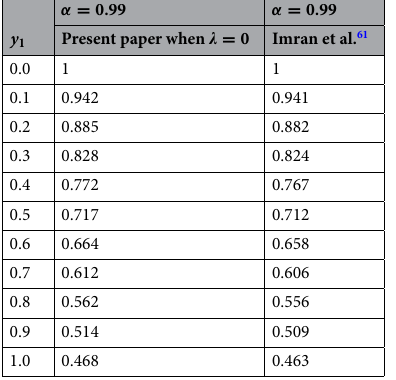
Table 2. Effect of fractional parameter on dimensionless velocity.